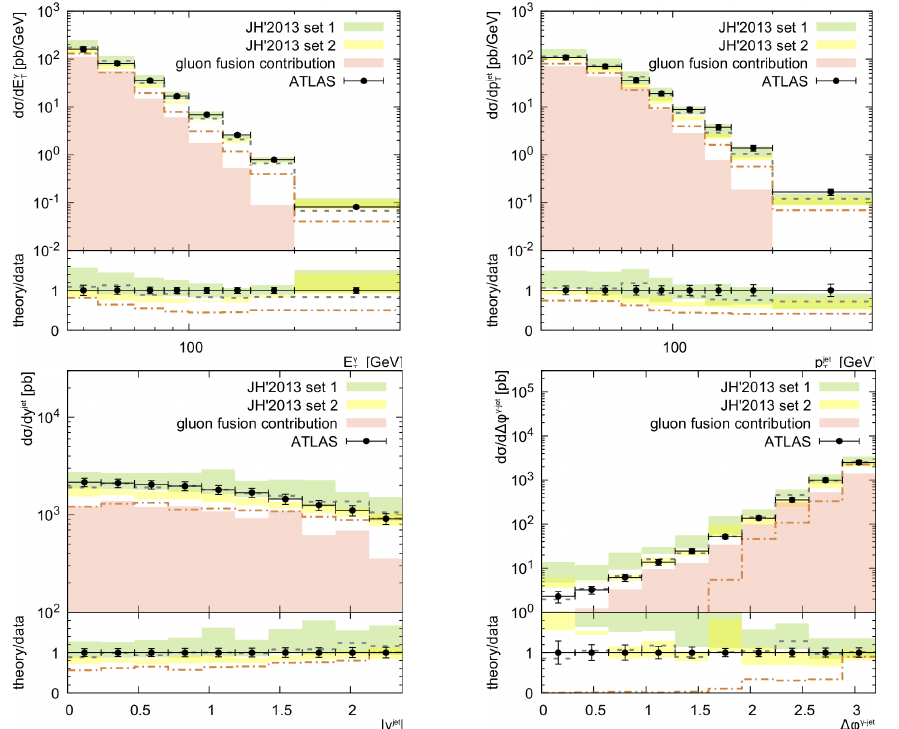
Figure 3. The di ff erential cross sections of associated prompt photon and jet production at √ s = 7 TeV as functions of photon transverse energy E γ , jet transverse momentum p jet , jet rapidity y jet and azimuthal T T angle di ff erence between the prompt photon and the leading jet ∆ φ . Notation of histograms is the same as in Fig. 1. The experimental data are from ATLAS[20].